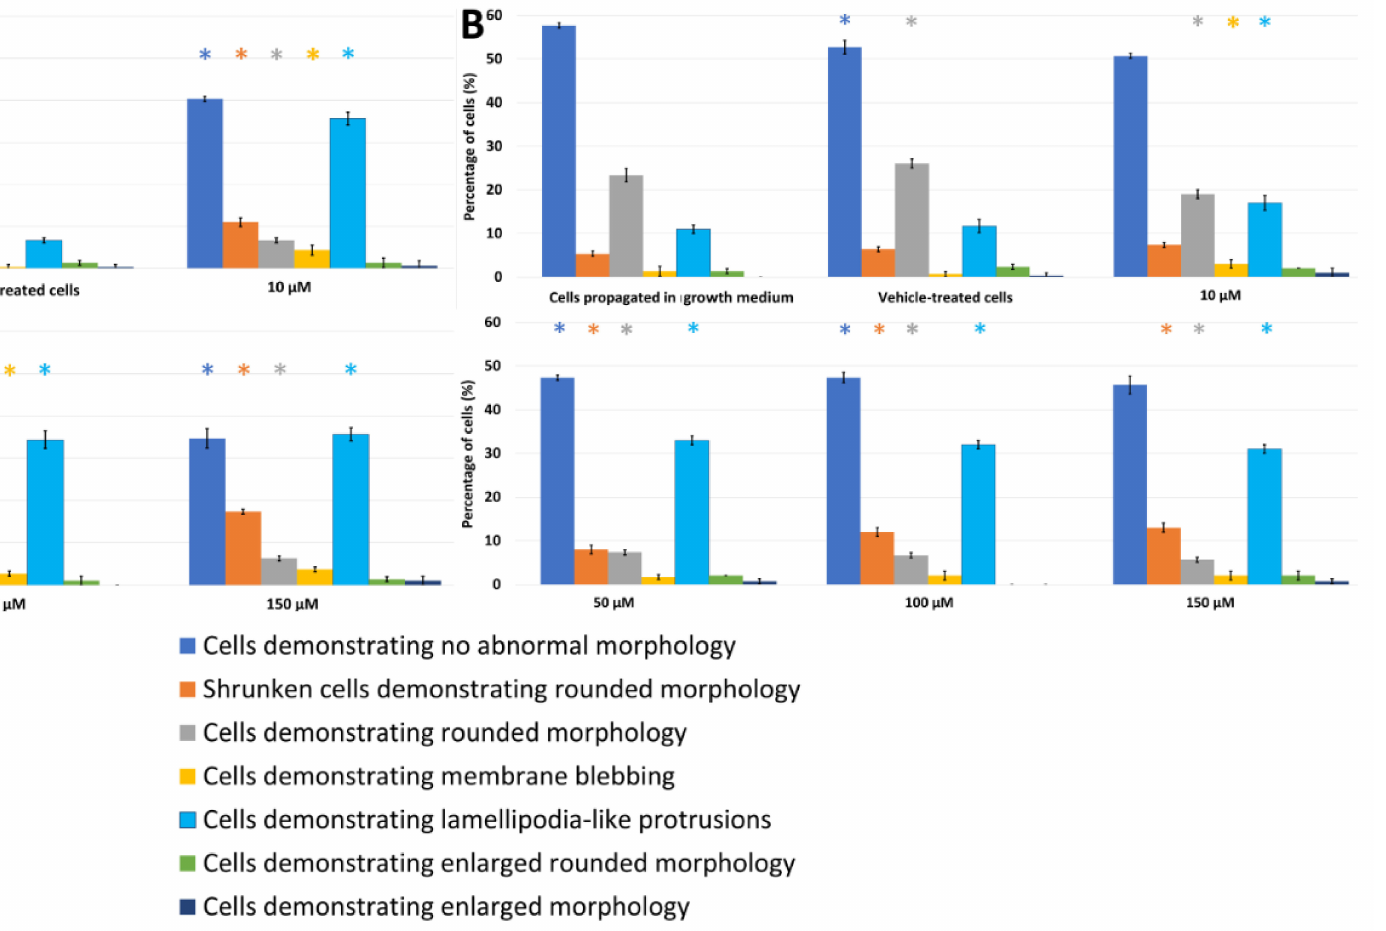
Figure 4. Light microscopy results demonstrating the effects of PPV (10–150 µ M) on cell morphology on DU145 cells at 48 h ( A ) and 72 h ( B ). Statistical significance is represented by an * when using the Student t-test with a p value of 0.05 compared to cells propagated in growth